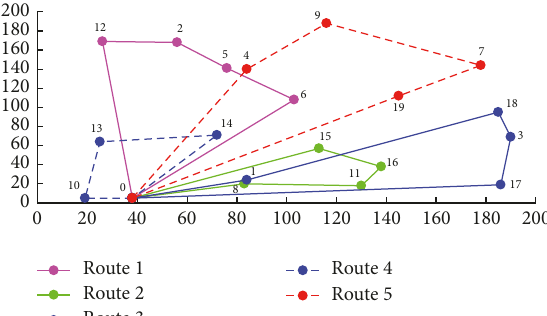
Figure 3: Plan of routes for Test Problem 2 ( 𝜔 = 2 ).